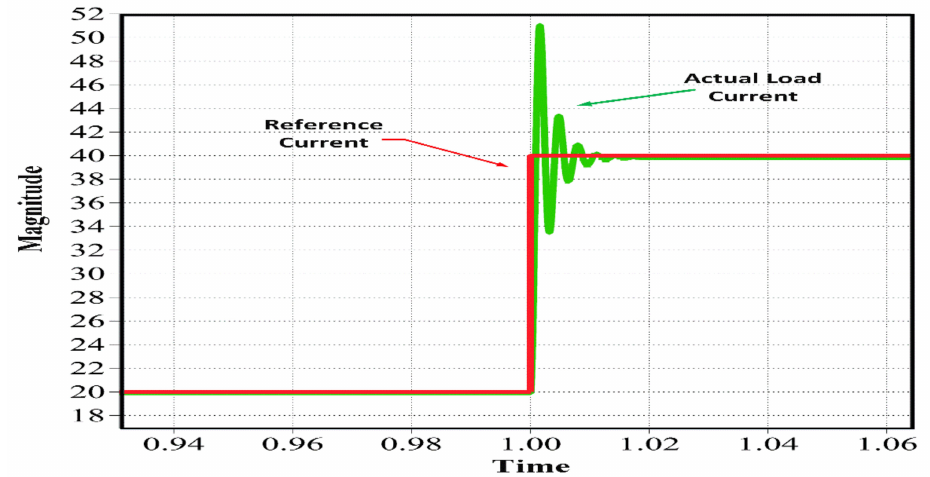
Figure 11. Tracking signals of reference generator current and actual generator current.